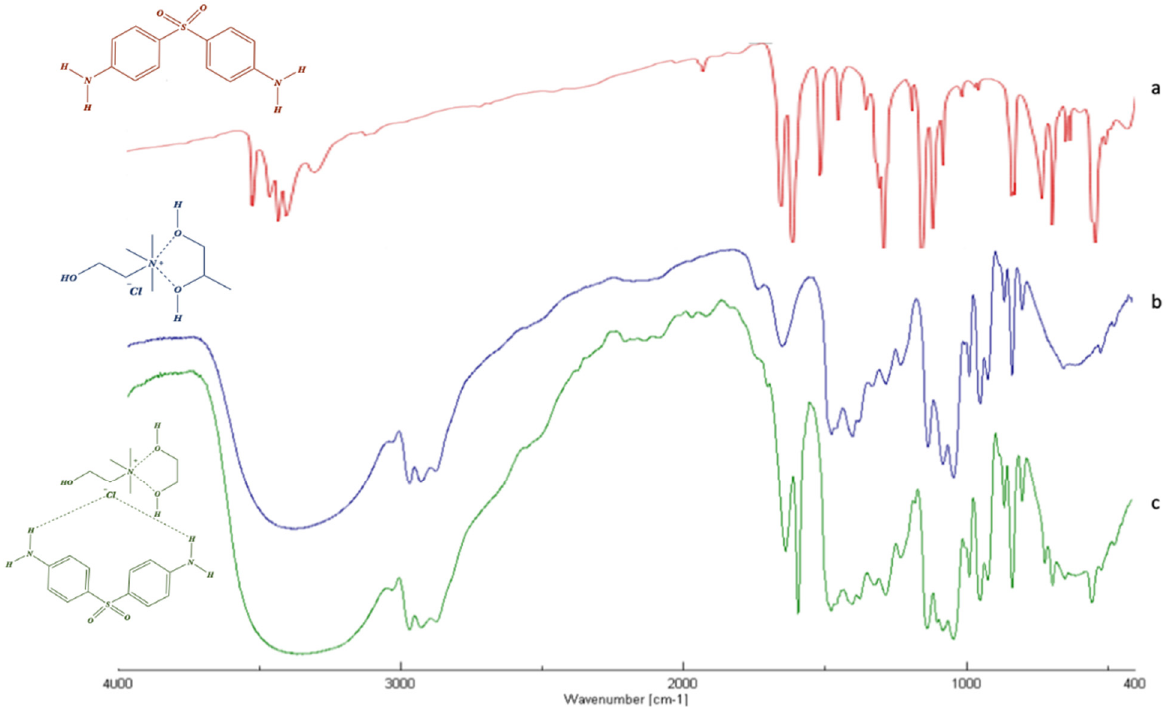
Figure 2. FT-IR of dapsone (red) ( a ), CC:PG DES (blue) ( b ) and drug-DES mixture (green) ( c